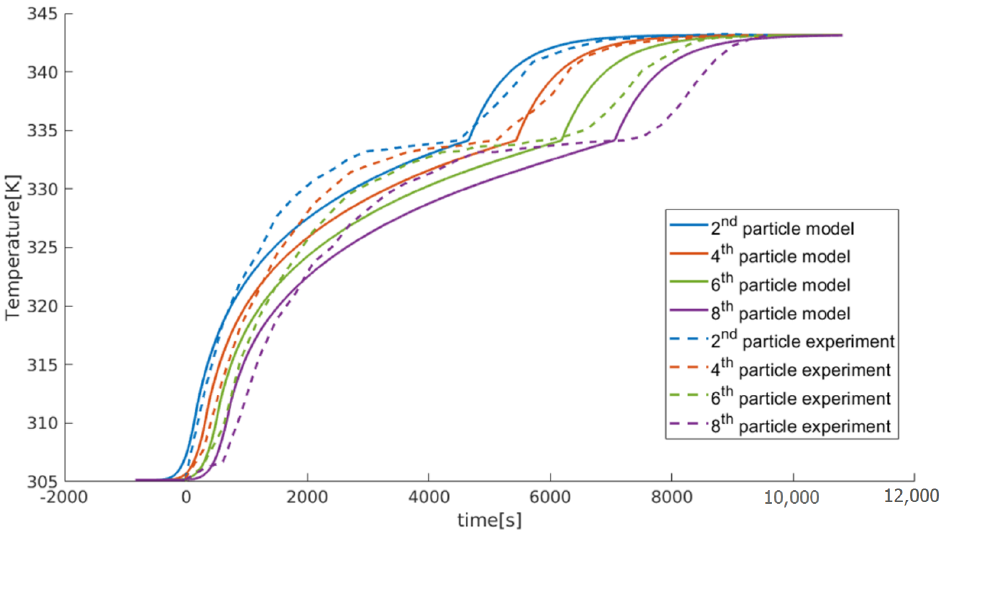
Figure 2. Comparison of the particle temperature at different locations between the experiment [11] and numerical solution.